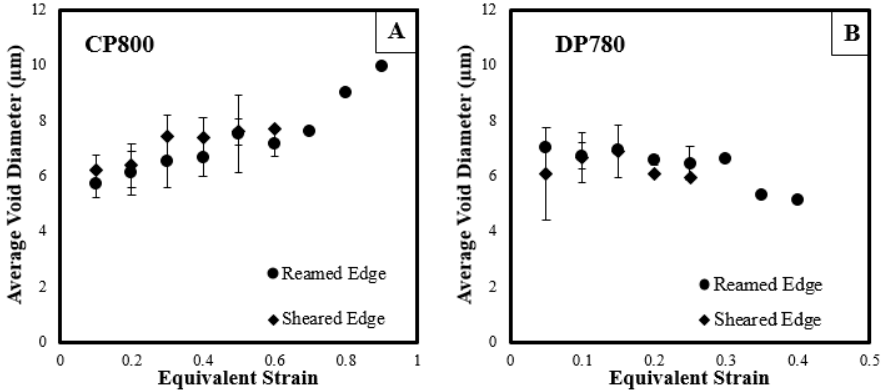
Figure 18. The variation of average void size during the deformation of ( A ) CP800; and ( B ) DP780. The void aspect ratio is defined as the ratio of the major to minor void diameters. The initial value of aspect ratio is dependent on the aspect ratio of nucleating particles that are initially aligned in the rolling direction. During deformation, voids grow in the loading direction that alters the aspect ratio with the variation in void shape due to deformation shown in Figure 19 for both the materials and edge conditions which remain nearly constant. The aspect ratio of individual voids is expected to evolve with the deformation but the average void aspect ratio remains unaffected during the deformation due to the continuous nucleation of voids.